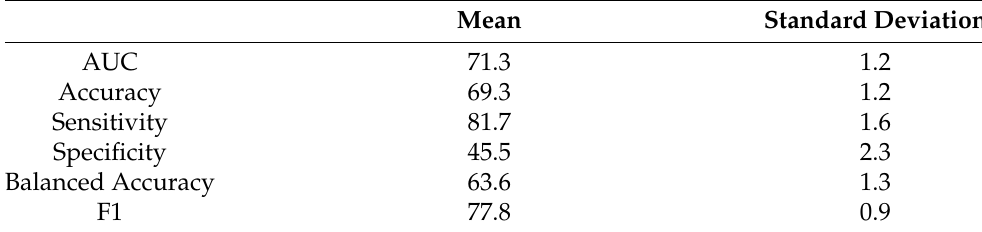
Table 2. Average performances of XGBoost over 20 runs of 10-fold cross